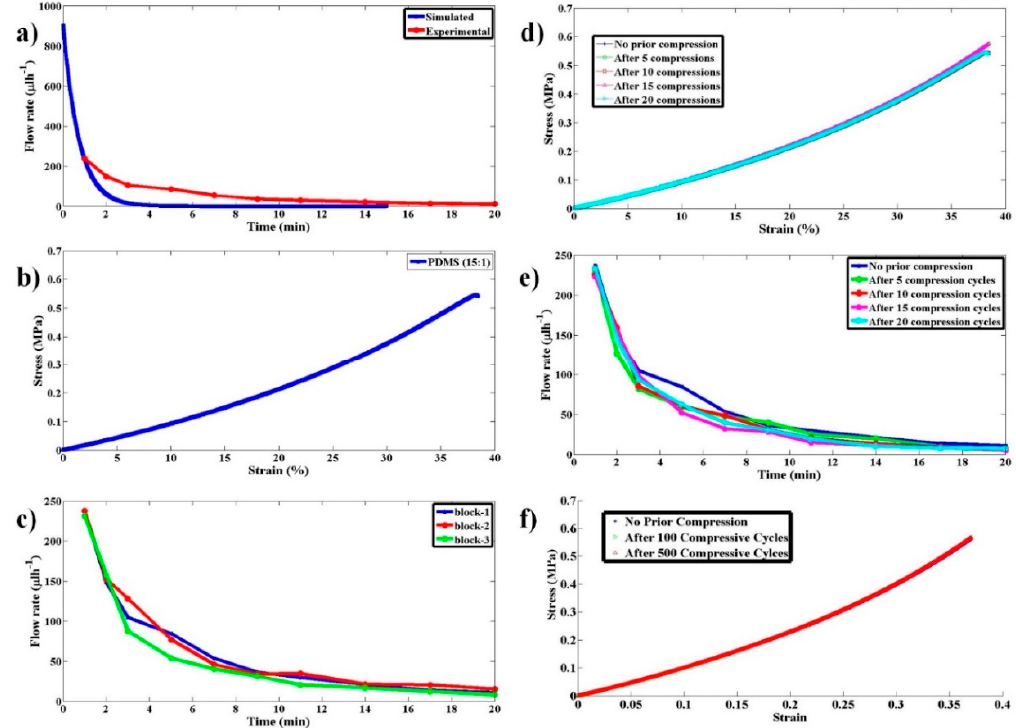
Figure 5. Studies on pump flow rate variation with time and its reproducibility and reusability as a multi-use pump. ( a ) Experimental and simulated flow rate as a function of time for the proposed pump when a PDMS block with 15:1 ratio was used. ( b ) The stress–strain curve for the PDMS block with 15:1 ratio. ( c ) Experimental flow rate as a function of time for the proposed pump when three PDMS blocks made under identical conditions, with 15:1 ratio, were used to test the reproducibility of the pump. ( d ) The stress–strain curve for the PDMS block with 15:1 ratio and have undergone 0, 5, 10, 15, and 20 compression-release cycles prior to using them for pumping. ( e ) Experimental data for flow rate as a function of time using the PDMS blocks that have undergone compression-release cycles as in (d). ( f ) The stress–strain curve for the PDMS block with 15:1 ratio and have undergone 0, 100, and 500 compression-release cycles prior to using them for pumping.